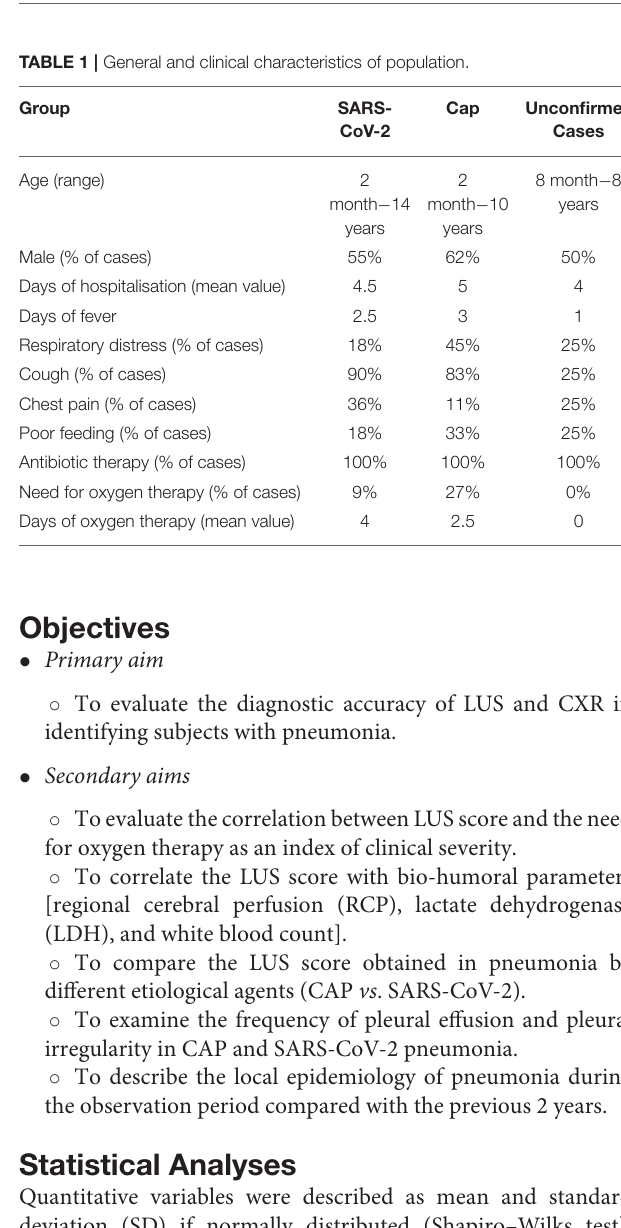
Cap Unconfirmed CoV-2